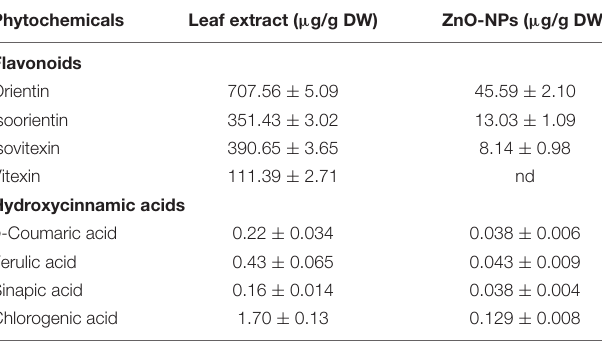
TABLE 2 | HPLC analysis of the A. publiflora leaf extract and biosynthesized ZnO-NPs. Phytochemicals Leaf extract ( µ g/g DW)